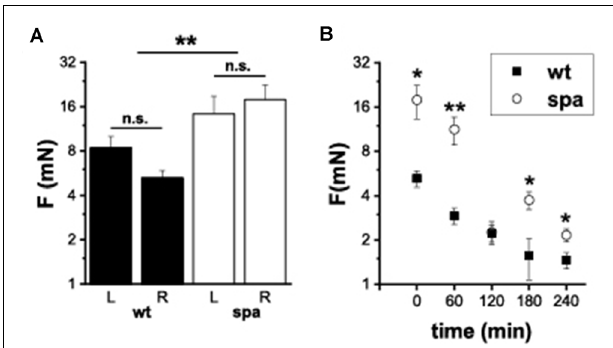
FIGURE 5 | Mechanically induced nocifensive behavior after zymosan A injection into the right hind paw. (A) Baseline reproducibility; mean withdrawal thresholds (L, left paw; R, right paw); there were no significant differences between the withdrawal thresholds of left and right paw subgroups. WTh’s were elevated in the spastic group. (B) Time course of mean WTh’s after zymosane A injection; both, spastic and wildtype mice develop allodynia. * p < 0.05; ** p < 0.01; n.s., not significant. Error bars indicating